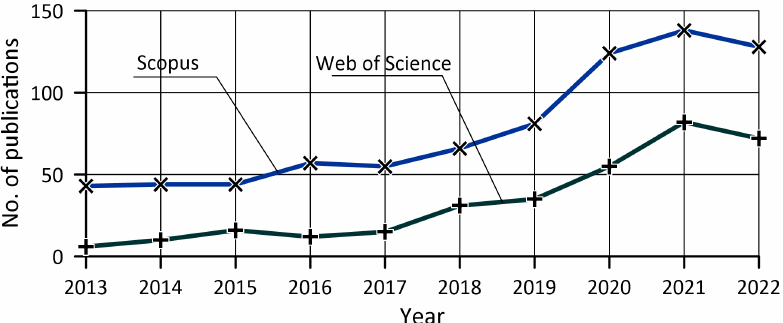
Figure 1. Number of Scopus- and WoS-indexed publications on AI methods in